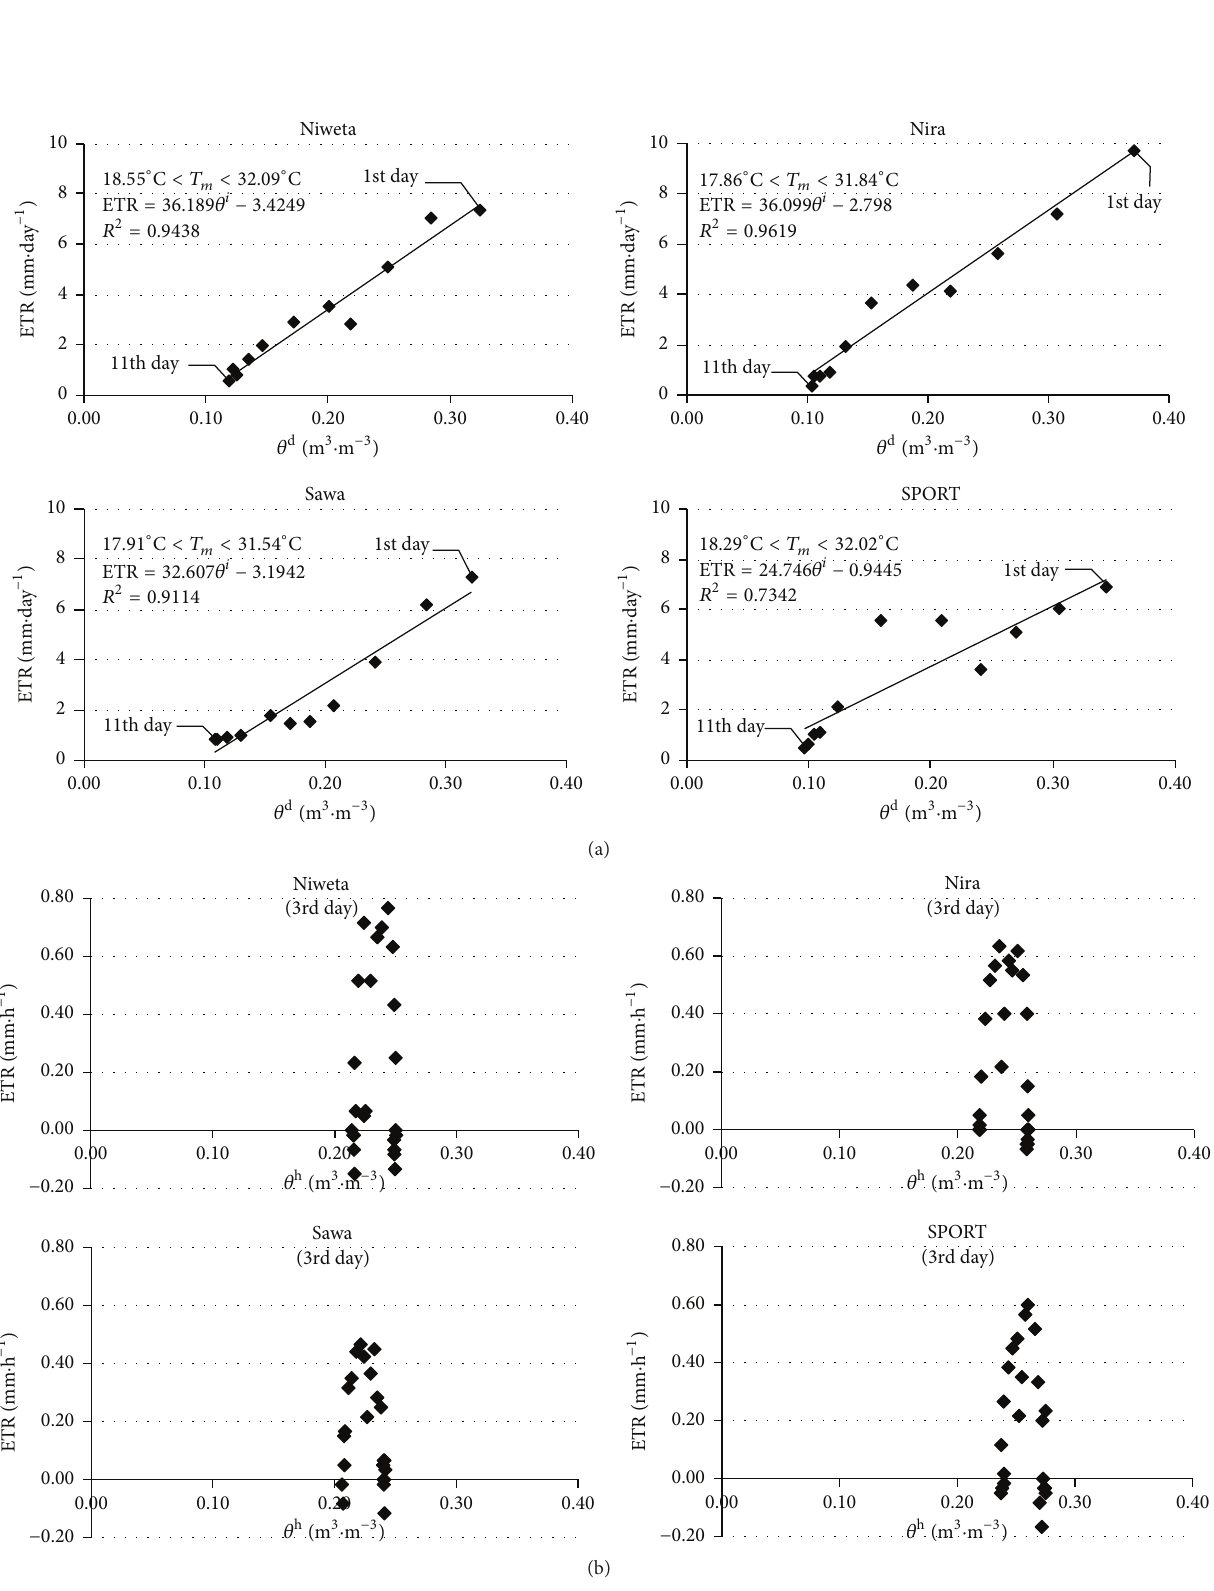
Figure 7: Relation of evapotranspiration to current moisture. ETR d is diurnal evapotranspiration, ETR h is hour evapotranspiration, 𝑇 𝑚 is mean temperature, and 𝜃 d ( h ) is mean diurnal (hour) moisture at the depth of 2.5